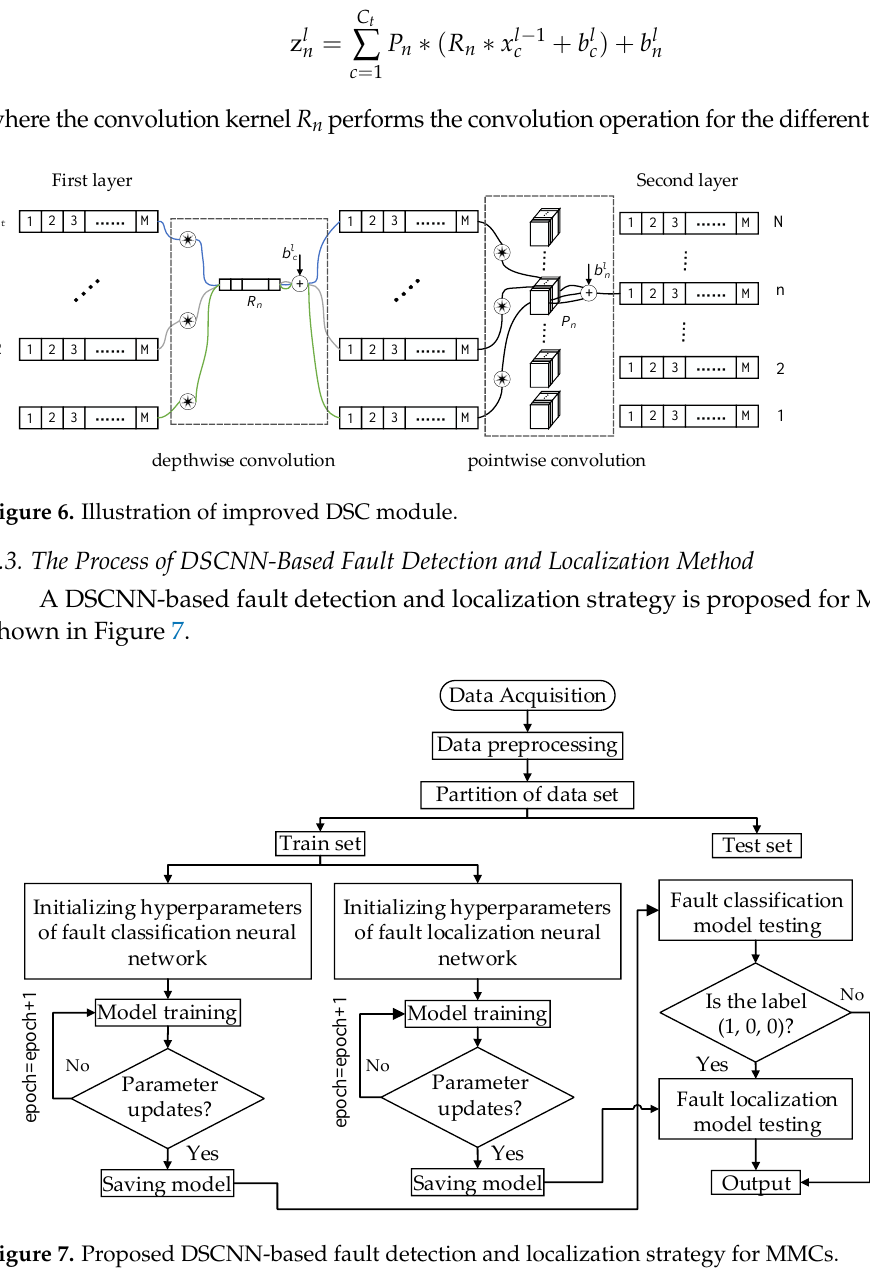
Figure 7. Proposed DSCNN-based fault detection and localization strategy for MMCs.